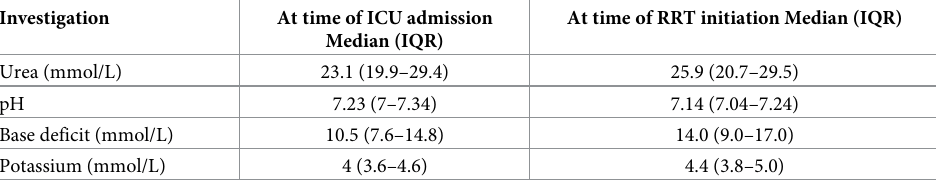
Table 5. Renal investigations of patients with severe leptospirosis requiring renal replacement therapy in Far North Queensland, Australia between 1997 and 2018. Investigation